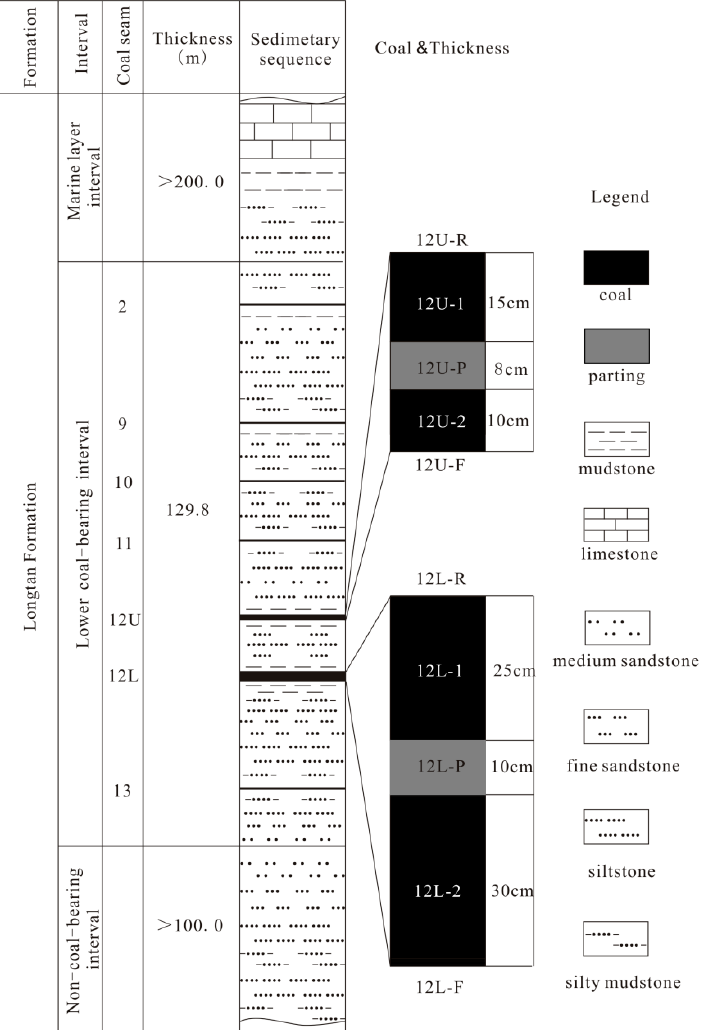
Figure 2. Sedimentary sequences of the Meitian Mine and bench samples used in this study.